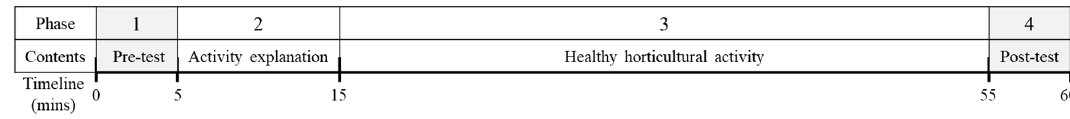
Figure 1. The operation process and time of the activity. Table 1. Activity titles, types, and objectives of the healthy horticultural activity program.